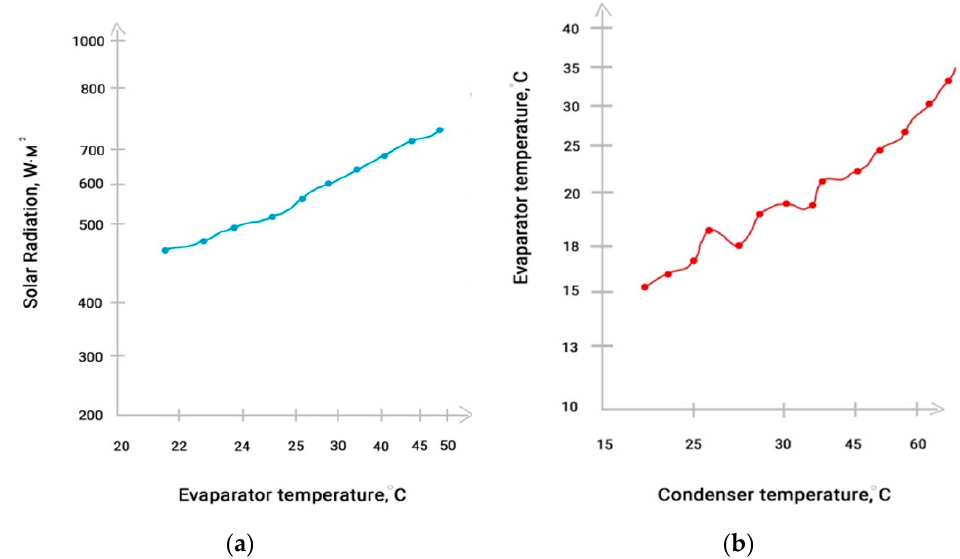
Figure 8. The evaporator temperature on the condenser temperature.